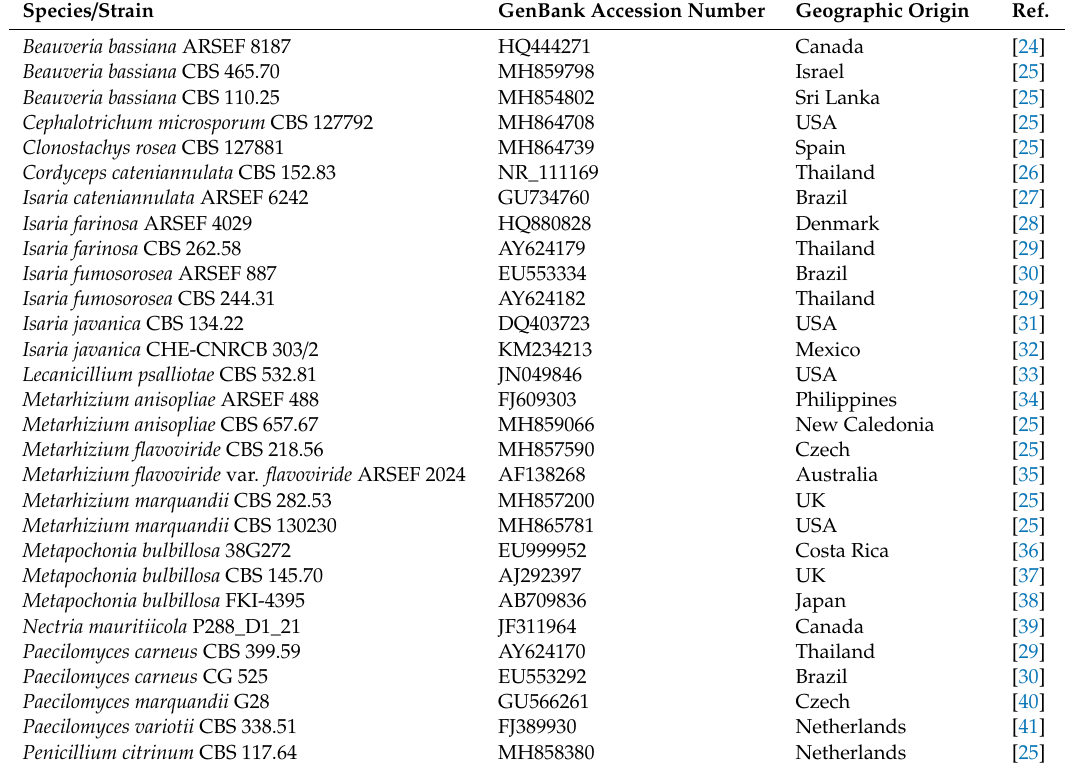
Table 1. The information of the referred fungal